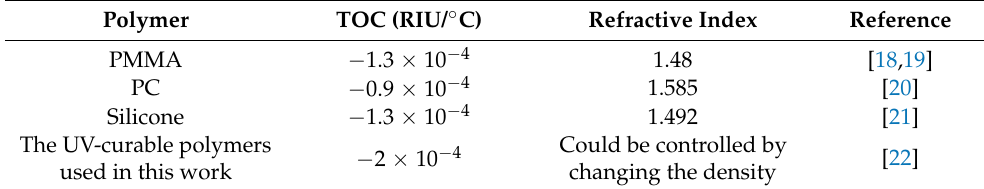
The UV-curable polymers used in this